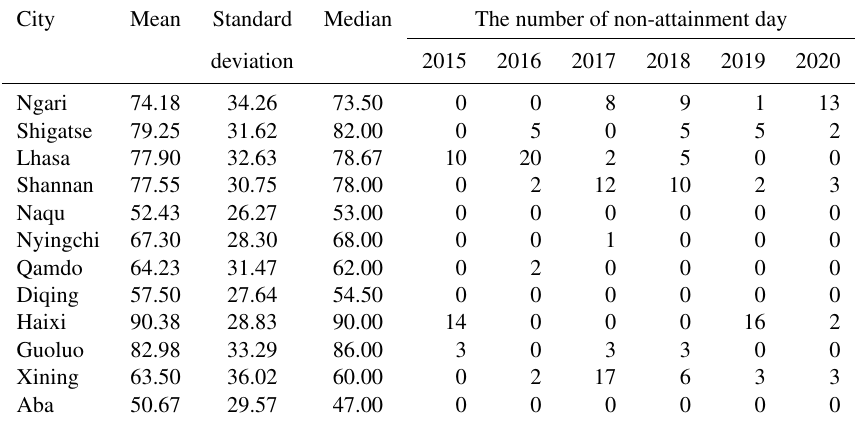
Table 3. Statistical summary of surface ozone concentration (units: µgm − 3 ) in each city over the QTP from 2015 to 2020. City Mean Standard